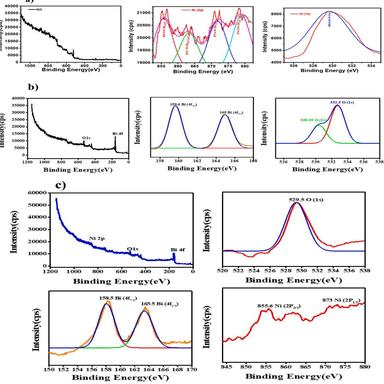
XPS spectra of pure a) NiO, b) Bi2O3 and c) NBO composite material.